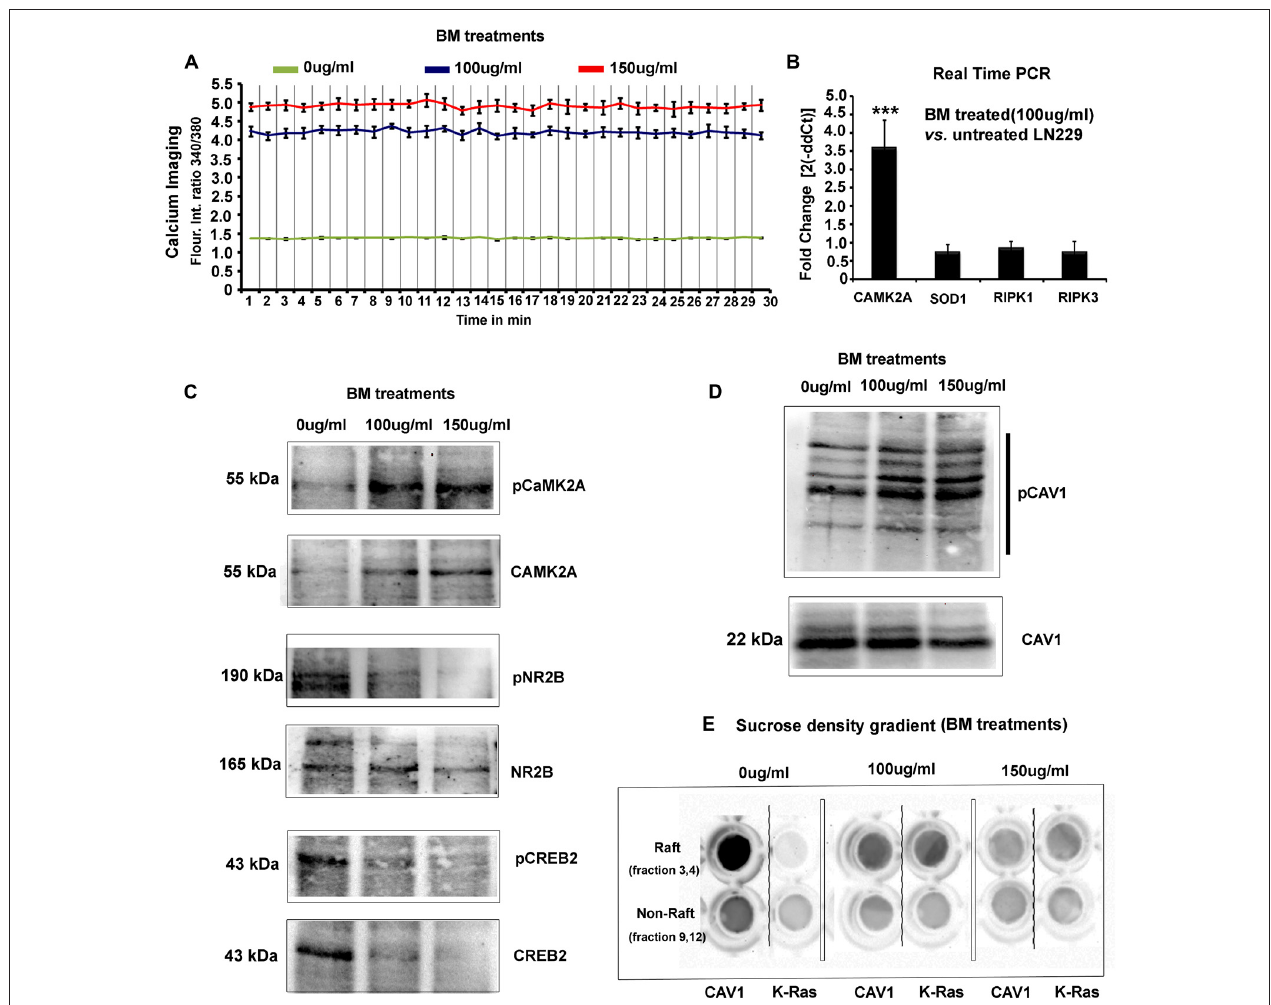
FIGURE 5 | BM induces imbalances in glioblastoma tumor cells physico-chemical homeostasis involving pCaMK2A T286-Ca 2 + axis. (A) As phosphorylated CaMK2A is known to trigger intracellular calcium release, free calcium flux, upon BM treatment were measured by Fura2-AM dye based ratiometric imaging. Results showed a 3–3.5 fold higher levels of free calcium in treated vs. untreated LN229 Glioblastoma cells (GC). (B) Real time PCR analysis to measure the fold change in the transcripts of CaMK2A (to measure the effects of BM on CaMK2A at a gene expression), SOD1 (to measure the tumor cell survival response to high calcium induced oxidative stress) and RIPK1/RIPK3 (to measure possible induction of necroptosis) was performed after 24 h of BM treatment at a dose of 100 µ g/ml. Significant increase in CaMK2A transcript vs. untreated LN229 glioblastoma tumor cells showed that BM acts by not only phosphorylating but also by increasing the pool of CaMK2A enzyme that can be phosphorylated. (C) Western blot analysis of the levels of pCaMK2A T286 vs . non-phospho CaMK2A upon BM treatment corroborates with the real time PCR results and shows that the levels of unphosphorylated CaMK2A is enhanced upon BM treatment and so does the pool of phosphorylated CaMK2A in treated vs. untreated conditions. This phosphorylation was unlikely due to the activation of NMDA-pCaMK2A pathway as major downstream signaling components, pNR2B and pCREB showed rather reduced levels in BM treated vs. untreated tumor cells. (D) Total cellular levels of CAV1 protein, also a marker of caveolae, showed a decrease at 150 µ g/ml but its Y14 phosphorylated form, which is essentially the CAV1 pool destabilized from the surface due to disassembly of caveolae showed a significant increase, suggesting that BM treatment generated higher membrane tension leading to loss of surface tension buffering caveolar reserves. (E) Sucrose density gradient combined with dot blot based determination of the levels of surface raft/caveolar caveolin vs. non raft/non-caveolar caveolin (fractions with non-raft marker protein K-RAS), showed that with BM treatment, less CAV1 protein was identified in raft fractions, suggesting a loss of caveolae/lipid rafts the from surface. ∗∗∗ p < 0.001. Error bar = SD The analysis is representative of three independent